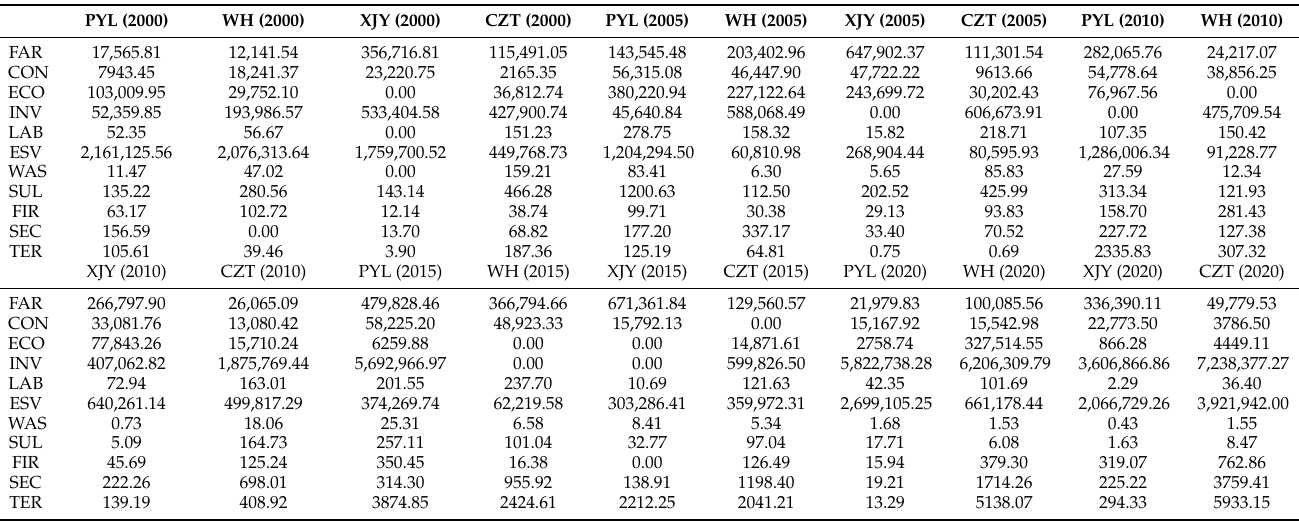
Table 3. Summary of slacks of input and output factors of the city